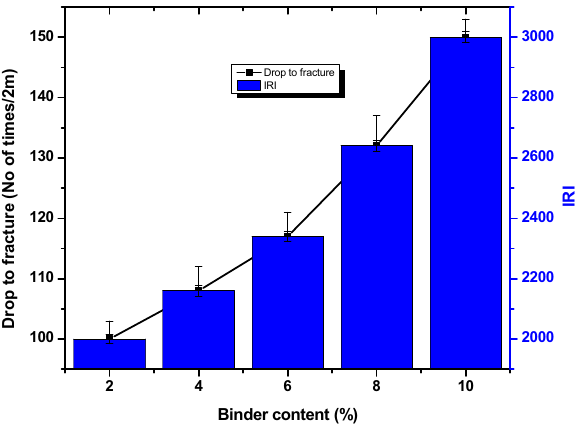
Figure 3. Drop to fracture and IRI for the fuel